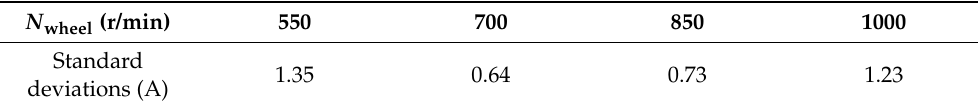
Table 2. The spindle current standard deviations of the grinding passes in Figure